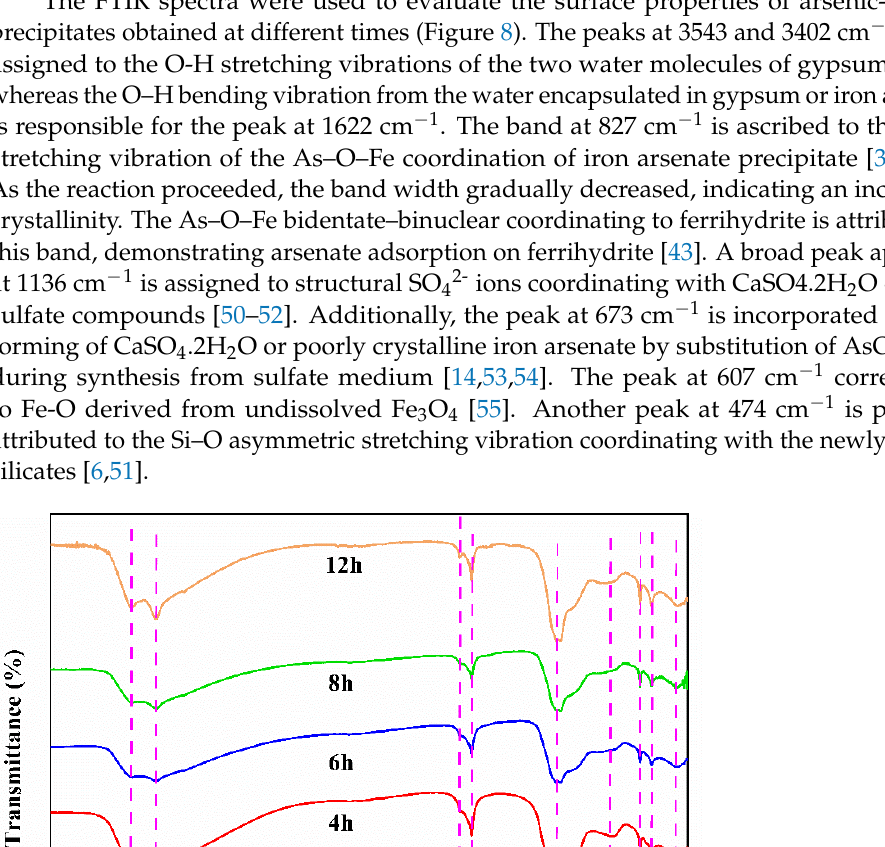
Figure 7. Variations of residual concentration and removal efficiency of As ( a ), leached arsenic con- centration in TCLP and final pH value of wastewater ( b ), residual concentration of Fe in bath exper- iments at reaction temperature of 25, 40, 55, 70, and 85 °C ( c ), XRD pattern of the arsenic-loaded precipitates obtained from bath experiments at reaction temperature of 25, 55, and 85 °C (solid – liquid ratio of 1:10 and H 2 O 2 volume ratio of 10%) and lead slag ( d ).